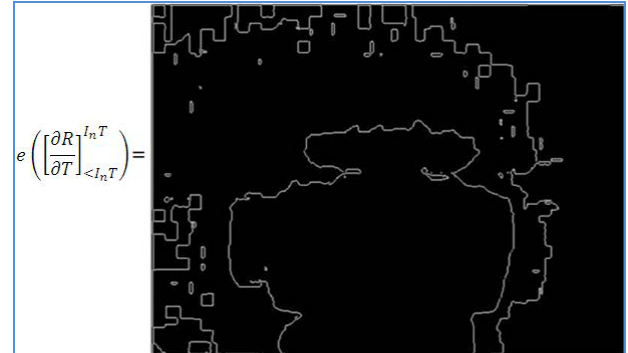
Figure 10. Temperature affected area at the reference point In the above figure, the consequent equation represents the thermal affected area at that 𝜕𝜕𝜕𝜕 certain temperature level. With the combination between � 𝑔𝑔 �� the partial deferential equation based area segmentation method and certain thermal chromatics value, : (0,12,241) shown in the thermographic image is implemented by the mathematical foundation based Color-Temperature Relationship